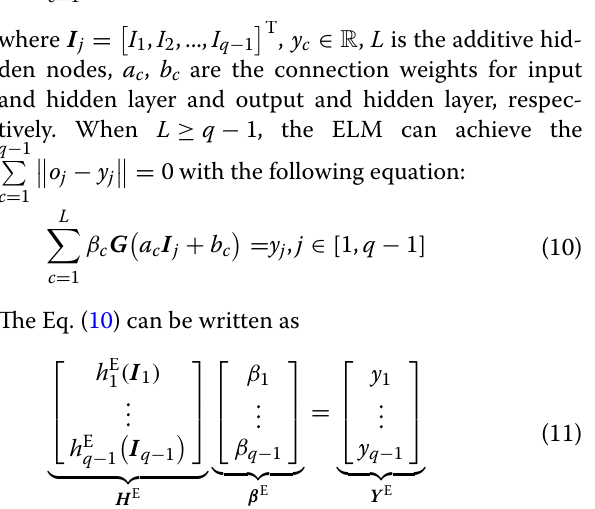
E can be computed as the